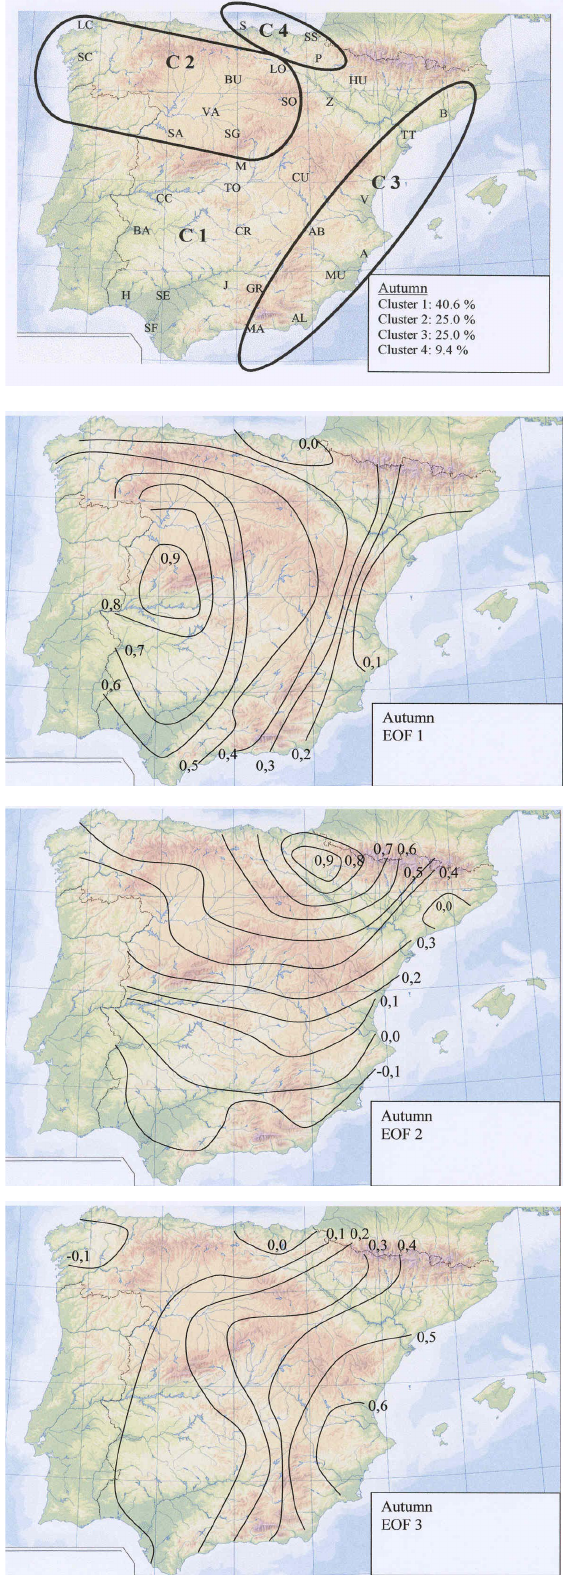
Fig. 9. As Fig. 6, for